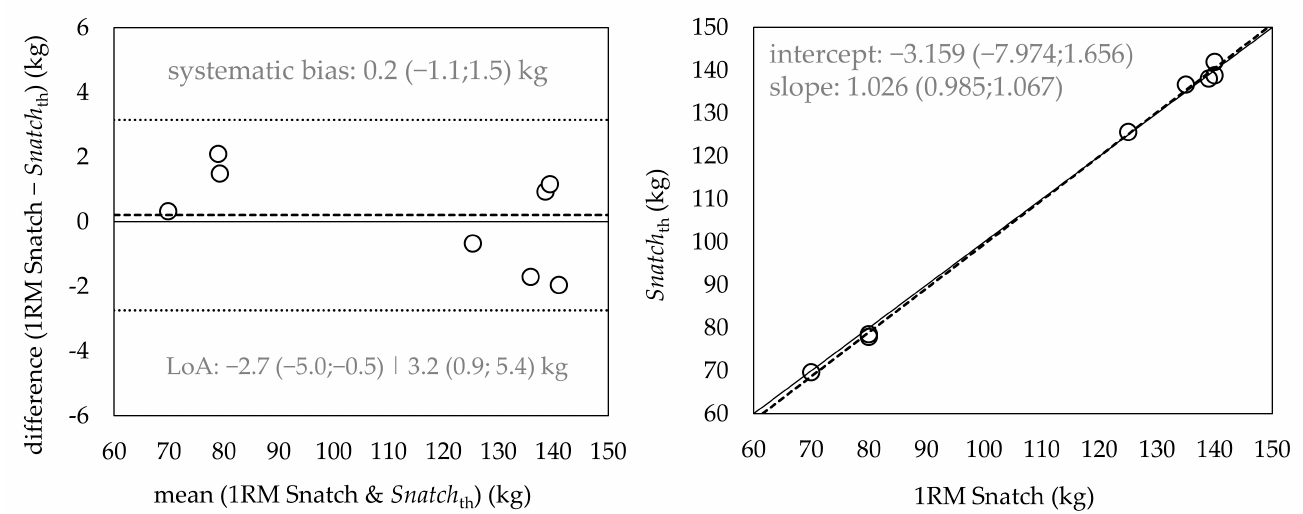
Figure 2. Results of the Bland–Altman analysis ( left ) and Deming regression ( right ) for the comparison between actual 1RM snatch and snatch th . The Deming regression plot illustrates the fitted linear model (dashed line) and the identity line (snatch 1RM = snatch th , slope = 1) (solid line). The Bland–Altman plot depicts mean differences between actual 1RM snatch and snatch th (dashed line) and 95% limits of agreement (dotted lines). Slope and intercept in the Deming regression plot are reported with 95% CL. The mean difference in the Bland–Altman plot is reported with 95% CL, and limits of agreement (LoA) are reported as systematic bias ± 1.96 × SDD with 95% CL. Snatch th = theoretical 1RM of the snatch computed from the snatch pull FvR 2 .